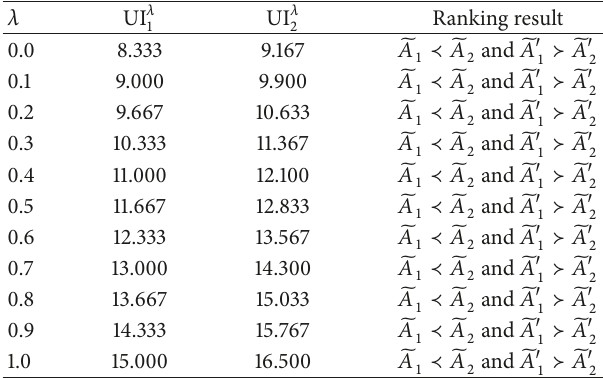
but overlapping after flipping and sliding movement. Here,